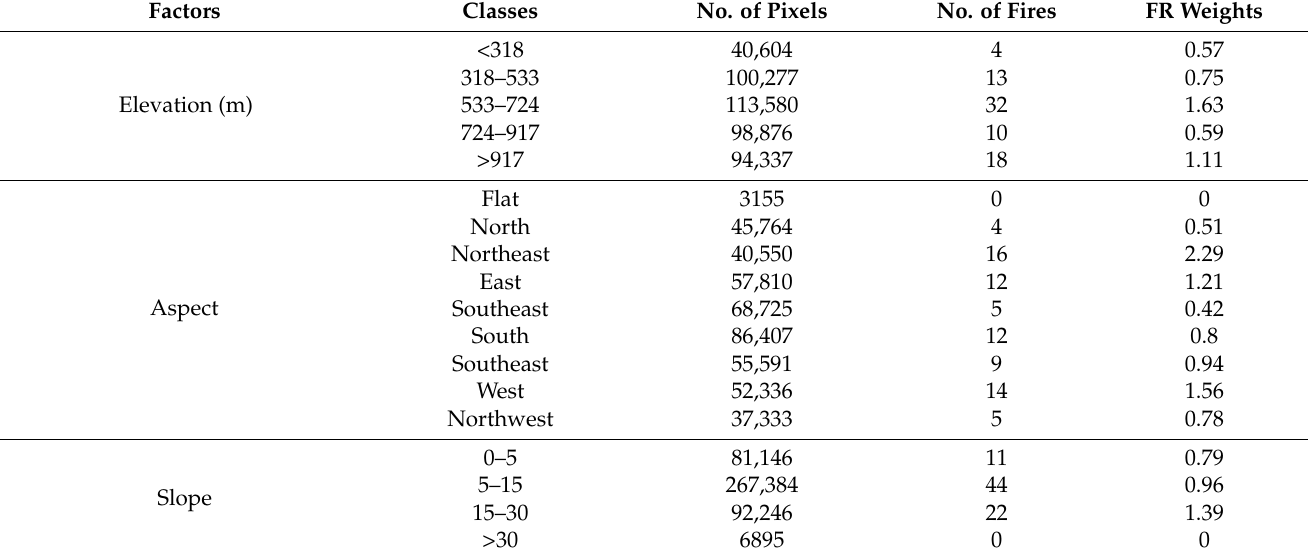
Table 2. Spatial Relationship Between each class of the factors and forest fire occurrence by the